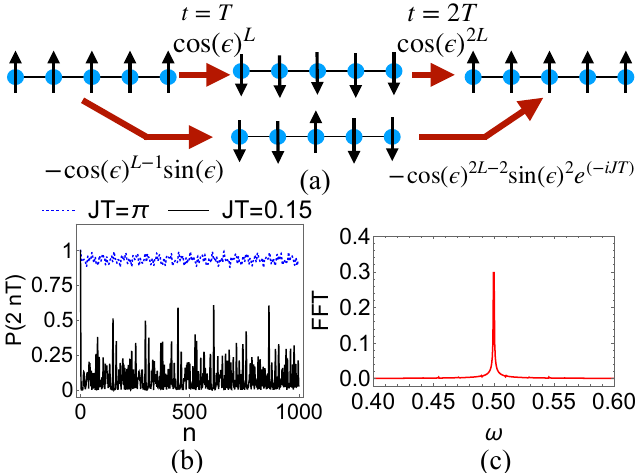
Figure 3. ( a ) Illustration of the state of the spin chain after two imperfect π pulses, starting from a fully spin-polarized state. After the first pulse the spin chain wavefunction primarily comprises two classes of states: A fully spin-polarized state, and L one-magnon states (i.e., a state with L − 1 spin-downs and one spin-up). When JT = π , the two pathways interfere constructively, leading to a revival of the initial state. ( b ) The stroboscopic return probability P ( 2 nT ) for two different values of JT , when (cid:101) = 0.07 π . Persistent oscillations can be observed when JT = π . ( c ) The Fourier spectrum of the return probability shows a robust peak at ω 0 /2, where ω 0 = 2 π , when JT = π T